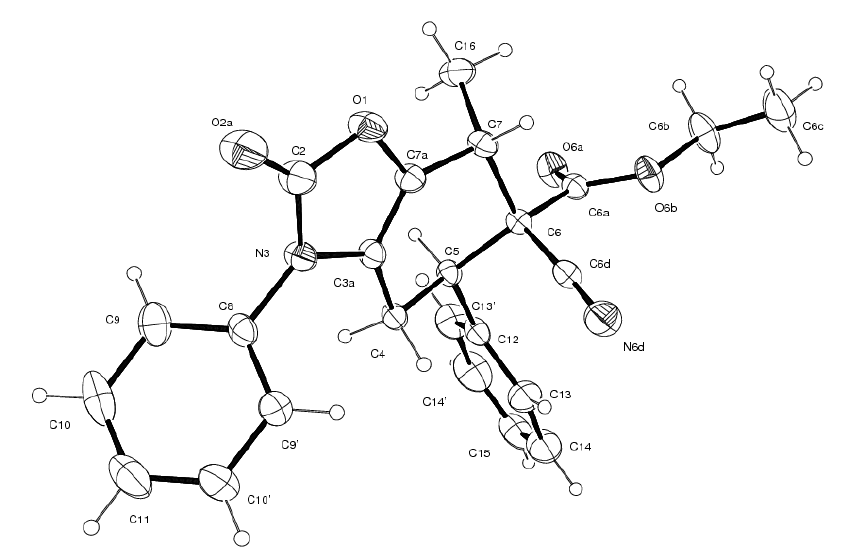
Figure 4. Molecular structure of 13a with thermal ellipsoids at the 30% probability